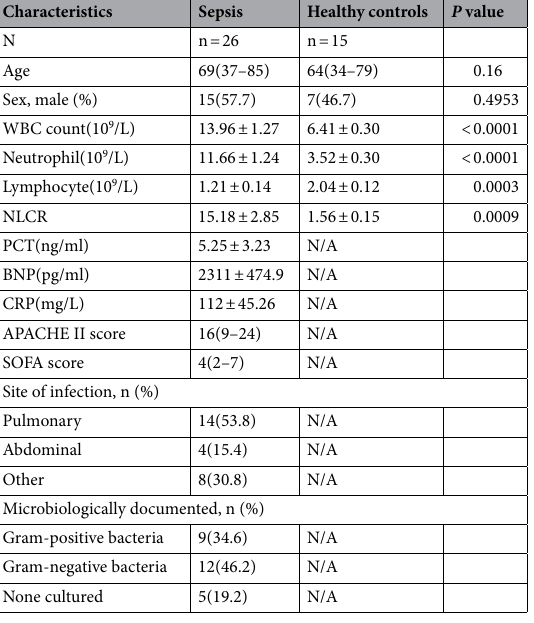
Table 1. Characteristics of healthy controls and patients with sepsis. Data presented as number (percentage) or mean (standard deviation). WBC white blood cell, NA not applicable, NLCR neutrophil–lymphocyte count ratio, PCT procalcitonin, BNP B type natriuretic peptide, CRP C-reactive